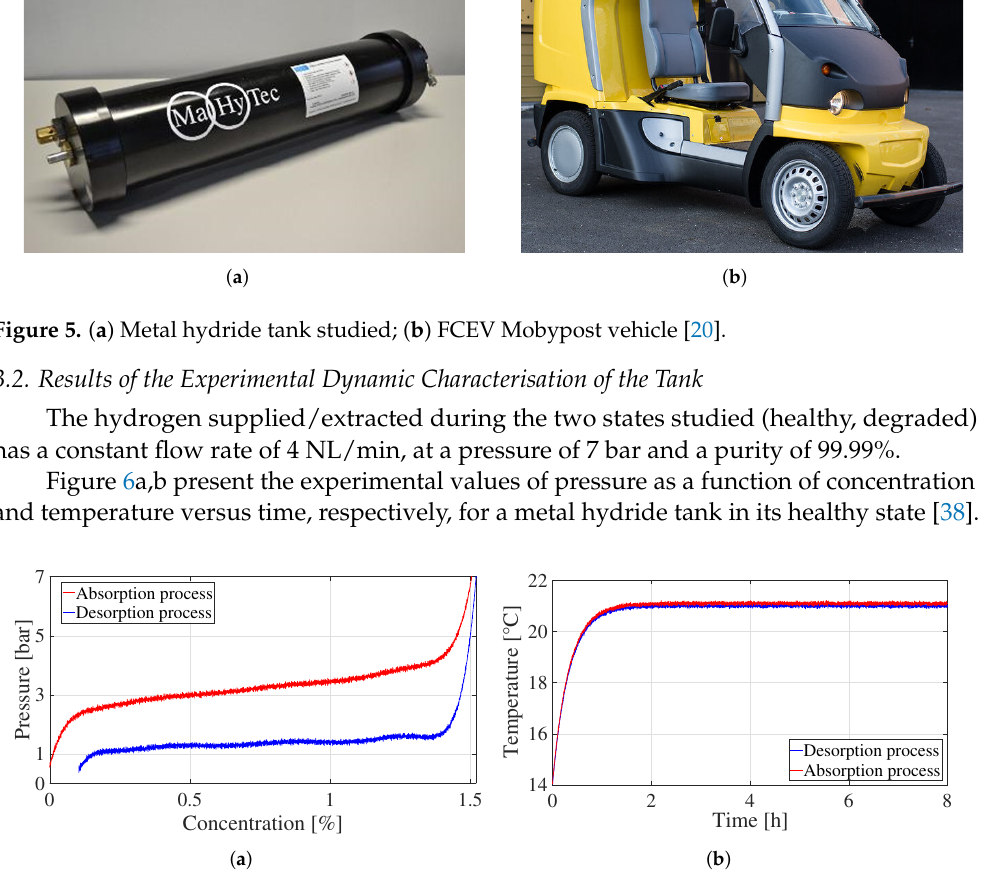
Figure 6. Healthy state of the tank: ( a ) Pressure versus concentration, ( b ) Temperature versus time [38].